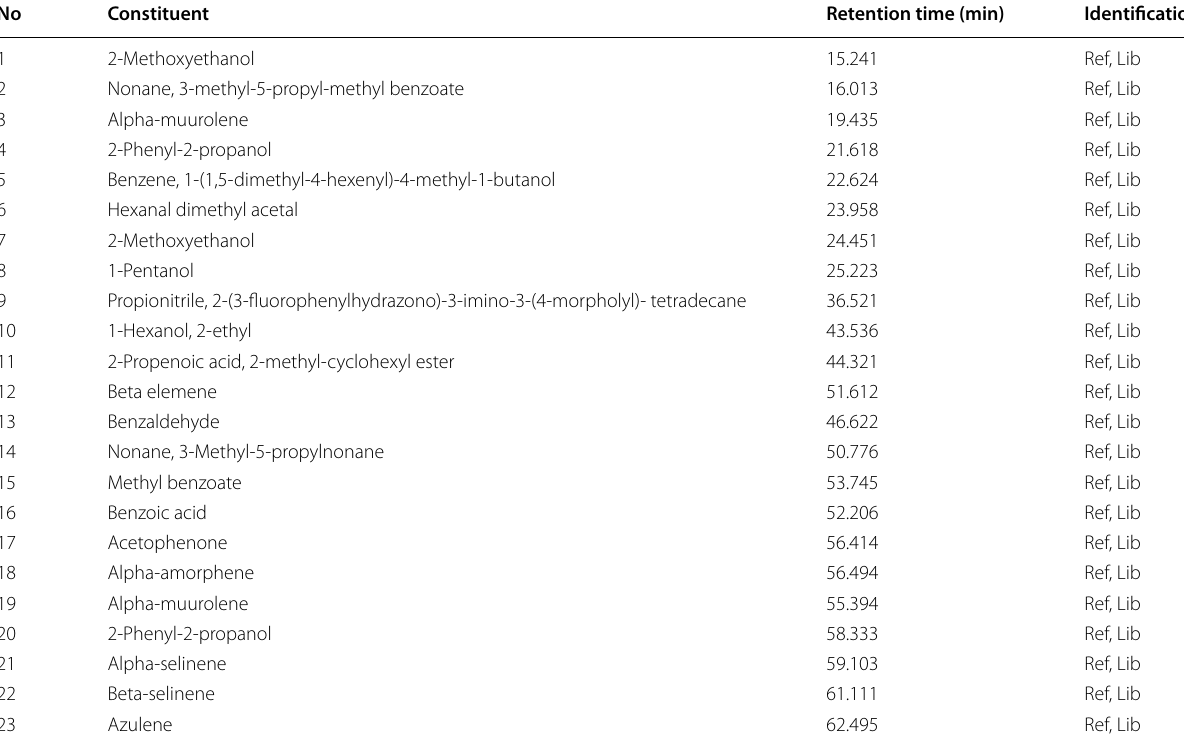
GC/MS comparison with GC/MS standard, Ref comparison with GC and MS literature values are expressed on the dry weight basis. The compounds obtained in the Ir extracts are given in Table 2.